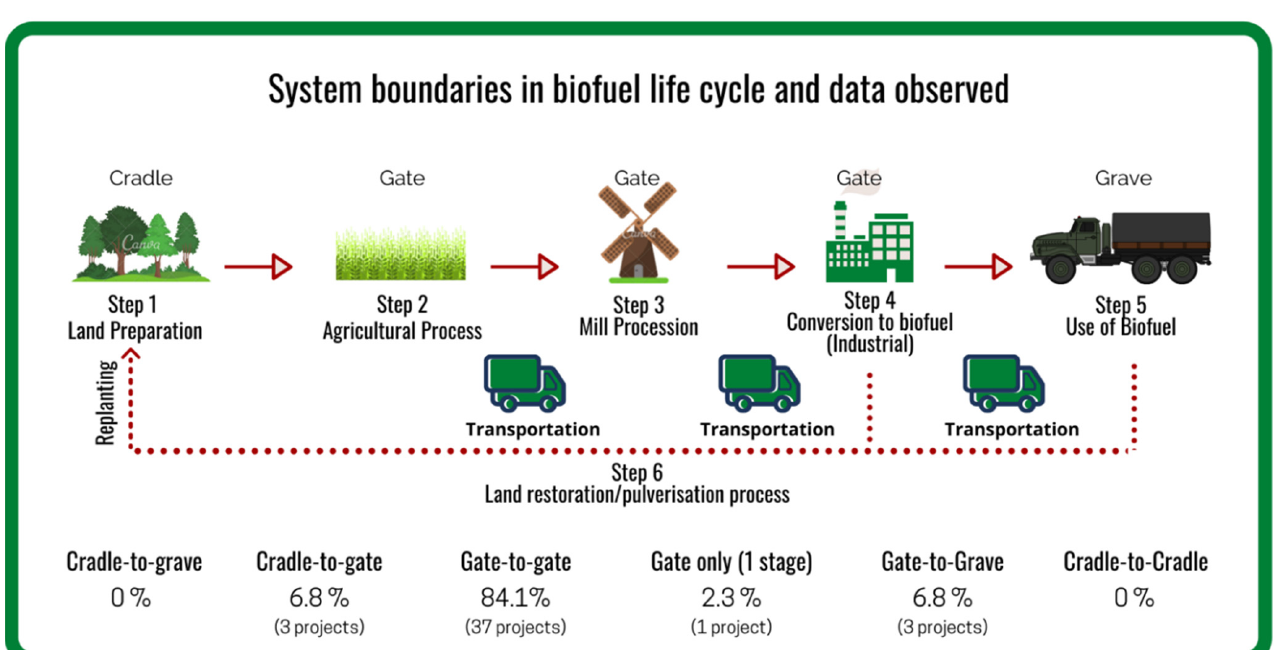
Figure 1. Biofuel system boundaries from the data observed. Source: authors.